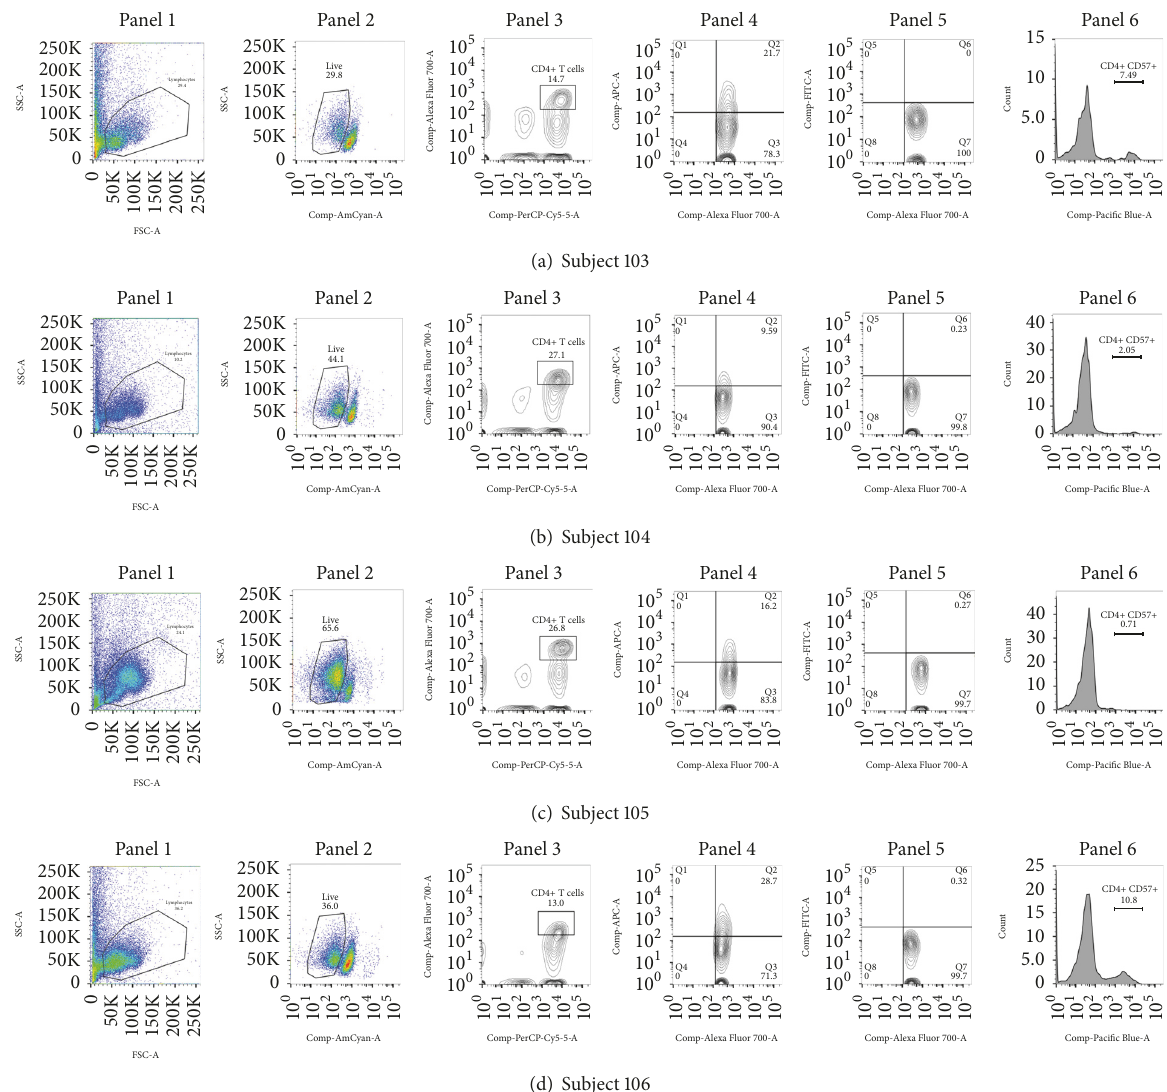
Figure 1: Flow cytometry results for CD4+ T cells. Panel 1: gating of lymphocytes; panel 2: live/dead staining; panel 3: CD3+ CD4+; panel 4: CD4+ HLA-DR+; panel 5: CD4+ CD38+; panel 6: CD4+